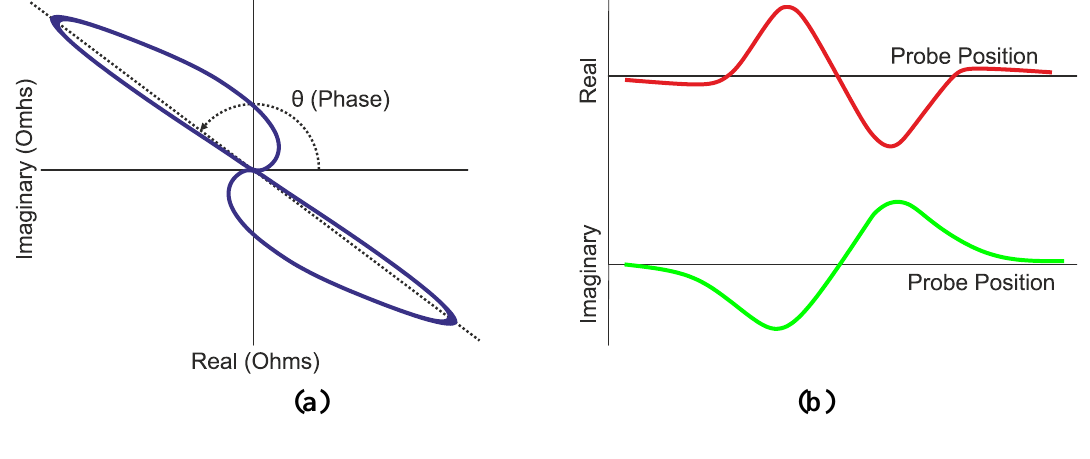
Figure 6. (a) Typical loop of a complex impedance plane of a differential probe inside a tube affected by a flaw (adapted from [13]). (b) Real and imaginary part of impedance change vs. time (adapted from